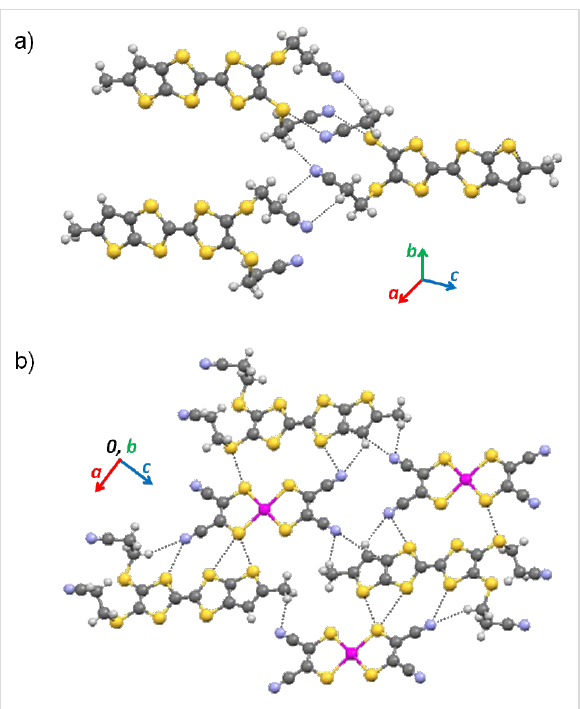
Figure 9: Detail of the crystal structure of 3 showing the short contacts between